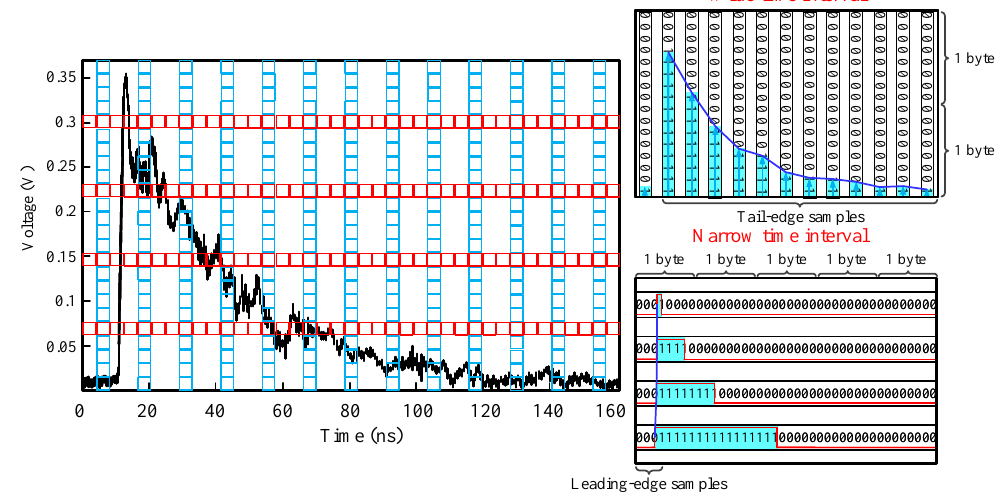
Figure 6. Illustration of the DTI method. The narrow time interval (horizontal) used to sample the fast leading edge by employs a few discriminators with programmable voltage thresholds to determine the time points when the scintillation pulse crosses the set thresholds. The wide time interval (vertical) used to sample the tail edge of the scintillation pulse employs a conventional analog-to-digital (AD)